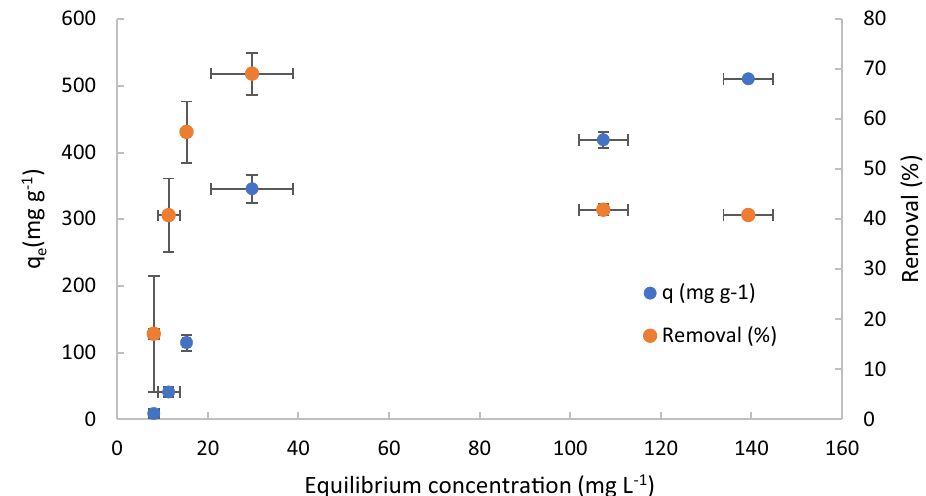
Figure 9. Equilibrium adsorption of DCF on TPEG. C 0 = 10, 20, 40, 100, 200 and 250 mg L −1 , pH 1, 10 mg of adsorbent material, stirring speed = 650 rpm, contact time = 10 min. Standard deviation for adsorption capacity and equilibrium concentration are also reported (some values are lower than the indicator